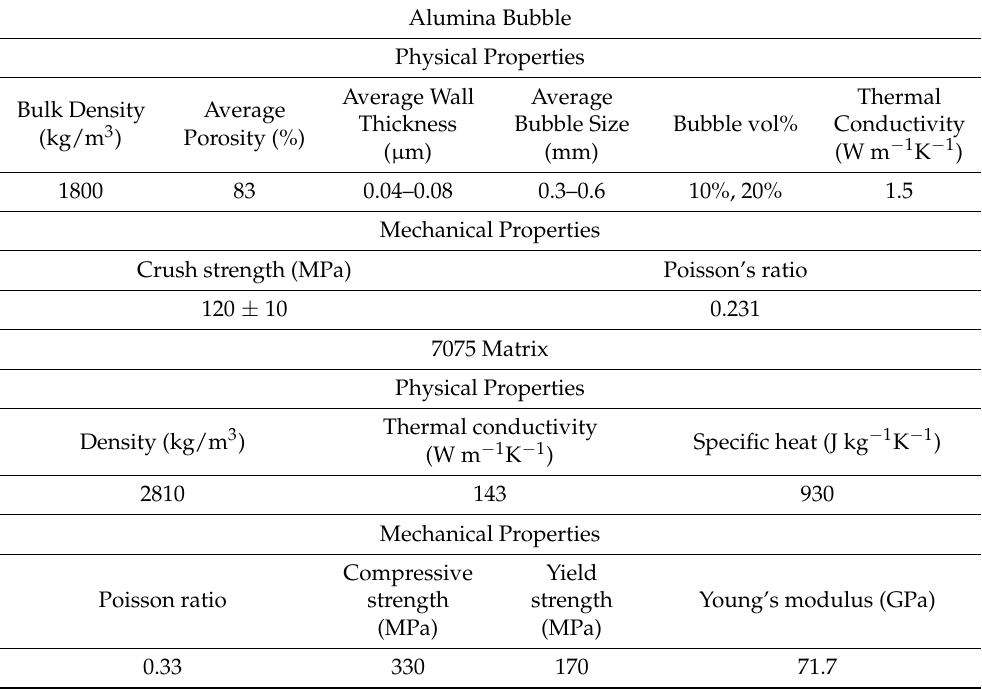
Table 2. Physical and mechanical properties of 7075 matrix and alumina bubble